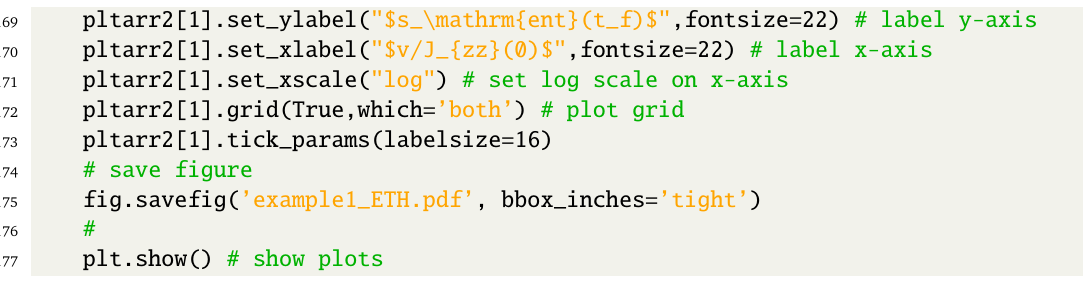
fig.savefig(’example1_ETH.pdf’, bbox_inches=’tight’) plt.show() # show